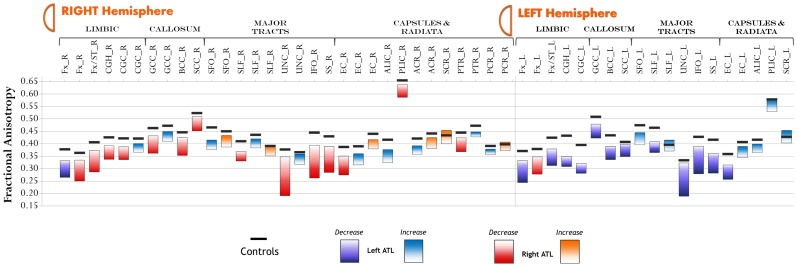
Amount of FA change for each tract pre-to-post surgery.Black lines represent average values in healthy controls. Abbreviations: Fx = body of fornix; Fx/ST = fornix (stra terminalis); CGH = cingulate of hippocampus (parahippocampal); CGC = cingulate of cingulate gyrus; GCC = genu of corpus callosum; BCC = body of corpus callosum; SCC = splenium of corpus callosum; SFO-superior fronto-occipital fasciculus; SLF = superior longitudinal fasciculus; UNC = uncinate fasciculus; IFO = inferior fronto-occipital fasciculus; SS = sagittal stratum; EC = external capsule; ALIC = anterior limb of internal capsule; PLIC = posterior limb of internal capsule; ACR = anterior corona radiata; SCR = superior corona radiata; PTR = posterior thalamic radiation.